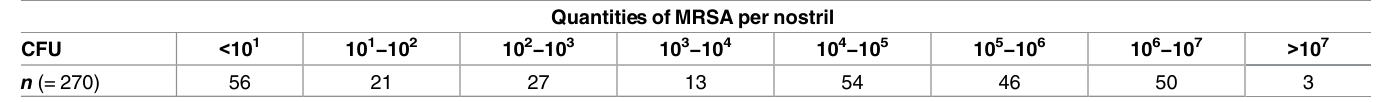
Table 1. Quantitiesof MRSA per